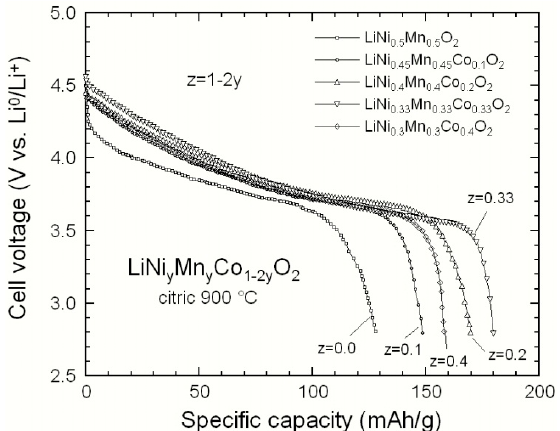
Figure 7. Typical discharge profiles of different Li//NMC cells with cathodes synthesized by the solid-state reaction route at 850 °C. The electrochemical test were carried out at discharge rate C/5 in the voltage window 2.8–4.6 V vs. Li 0 /Li + .